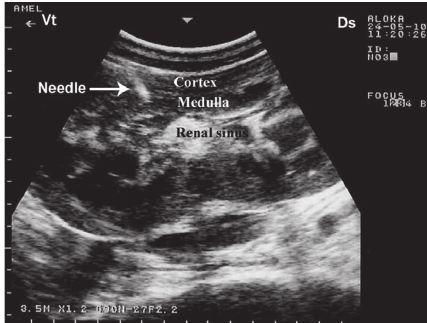
Figure 8: Renal biopsy in a camel. The needle is clearly visible within the renal cortex as a sharp bright line. Ds � dorsal; Vt � ventral.